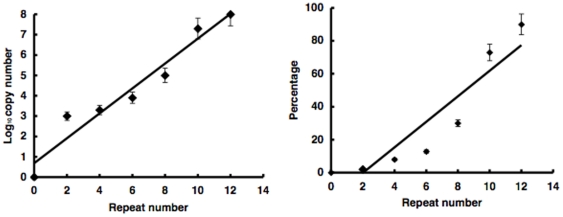

In vitro integration using modified or variable-length target sequences.Number of PIAP copies from integration into variable-length repeat sequences (left). Line represents a linear regression between the logarithm of copy number and number of repeated x, y units. The correlation coefficient was equivalent to 0.96. Repeat number 0 indicates that plasmid DNA was used as the substrate. Error bars represent standard deviation (S.E.). Percentage of PIAP copies from integration into the variable repeat sequences against that from integration into the whole sequence (right). Line represents linear regression between the percentage and number of repeated x, y units. The correlation coefficient was equivalent to 0.92. Error bars represent standard deviation (S.E.) (*P<0.001).